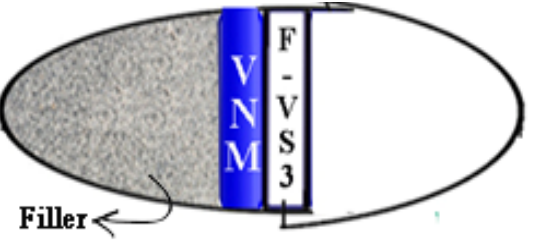
Figure 6. “Tab in cap” system for VS with filler (Lactose-200 mg).